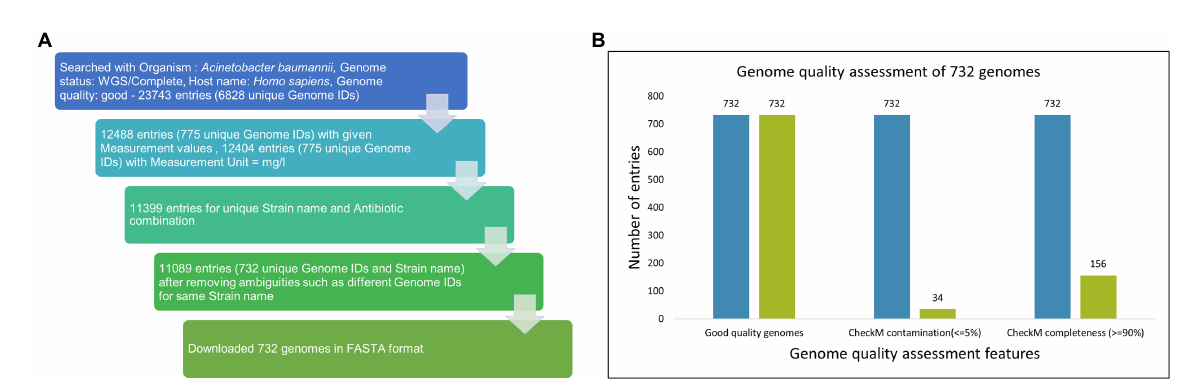
FIGURE 2 (A) Data mining from PATRIC. The drug sensitivity profile for isolates of AB (till 1 July 2022) were obtained from PATRIC (14) using keyword search with “ Acinetobacter baumannii ” and resulted in 23,743 entries. Several filters, namely Host: Homo sapiens; Genome quality: Good; Genome status: WGS/ Complete, were applied on this dataset, and incomplete entries with no MIC values and duplicate entries were removed. (B) Among 732 good quality genomes (as defined by PATRIC), CheckM contamination ( ≤ 5%) is reported for 34 and CheckM completeness (>=90%) is reported for 156